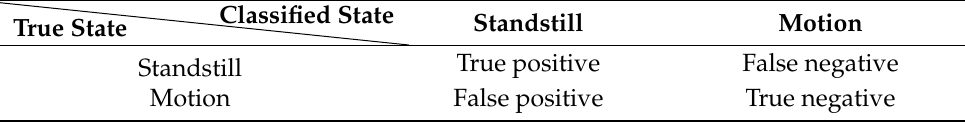
Table 1. Standstill